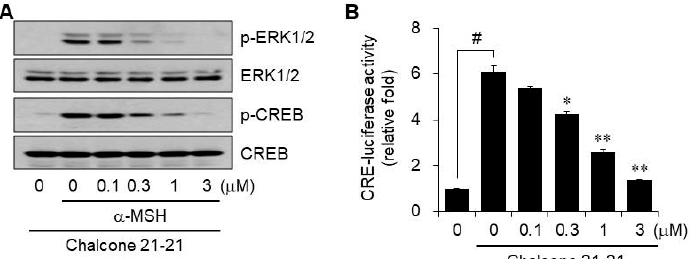
Figure 5. Chalcone 21-21 inhibits ERK and CREB signaling. ( A ) B16F10 cells were incubated for 1 h with vehicle (0.1% DMSO) alone or with various concentrations of chalcone 21-21 in the absence or presence of α -MSH (10 nM). The levels of phospho-ERK1 / 2, ERK1 / 2, phospho-CREB, and CREB were determined by Western blot analysis. GAPDH served as a loading control. ( B ) B16F10 cells were transiently transfected with a reporter construct of CRE together with the pRL-TK. The cells were incubated for 24 h with vehicle (0.1% DMSO) alone or with various concentrations of chalcone 21-21 in the absence or presence of α -MSH (10 nM). Luciferase activity was measured and firefly luciferase activities were normalized to that of Renilla luciferase. Results are represented as mean ± SD from three independent experiments ( n = 3). p -values of # p < 0.005 compared to the vehicle-treated group and * p < 0.05 and ** p < 0.005 compared to the α -MSH-treated group were considered statistically significant.